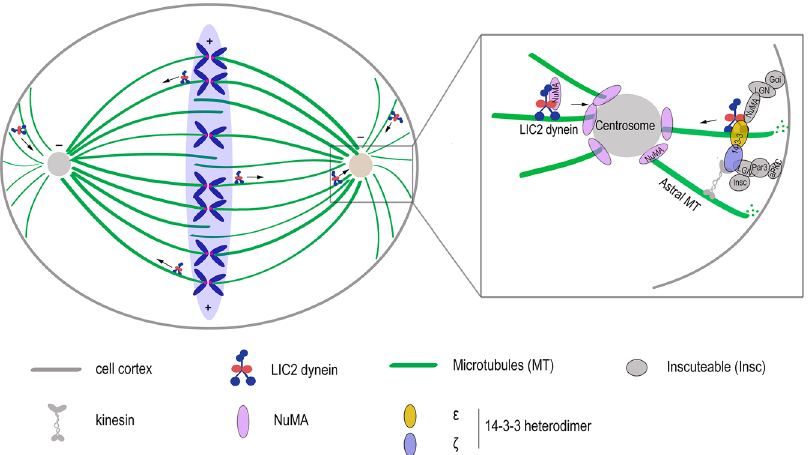
Figure 8. A model for LIC2-dynein based control of mitotic spindle orientation. LIC2-dynein interacts with NuMA, Par3 and 14-3-3 and anchors astral microtubules to the cortex. LIC2-dynein also transports cortical NuMA along astral microtubules to the spindle poles, thus helping to focus microtubule minus ends at the centrosome. LIC2 dynein may stabilize the bridging of the NuMA- and Par3-mediated spindle orientation pathways through its interaction with the 14-3-3 ε / ζ